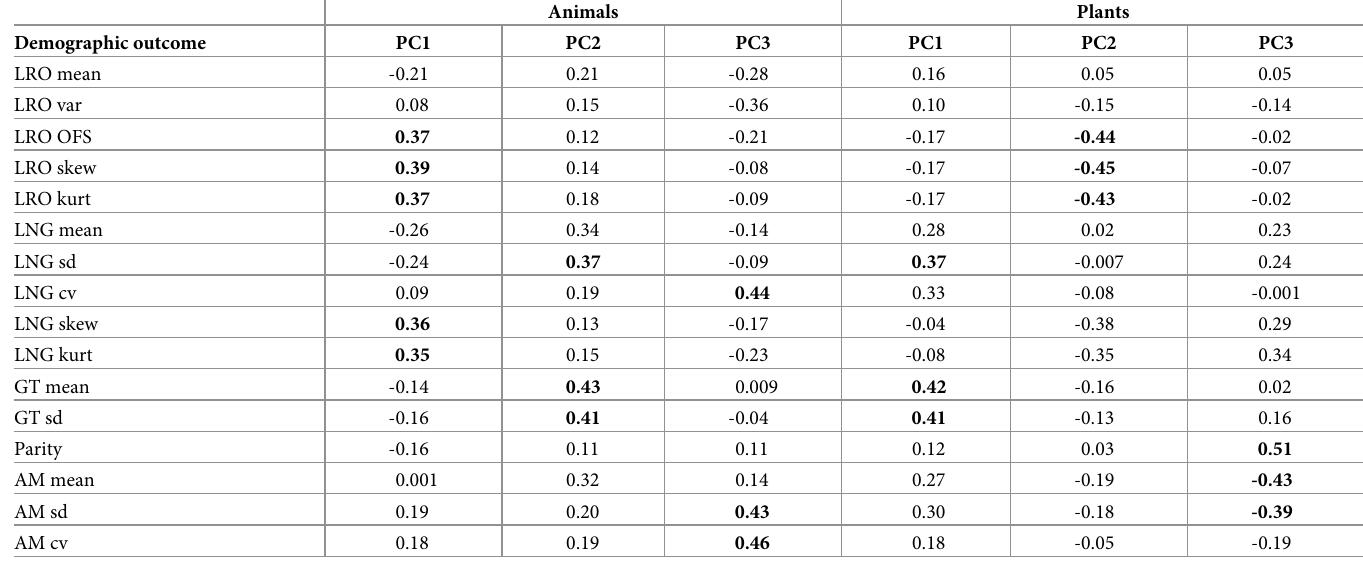
Table 2. Loadings of lifetime reproductive output (LRO), longevity (LNG), generation time (GT), modes of parity (Parity), and age at maturity (AM) on the first three principal components of animals and plants. Animals Plants Demographic